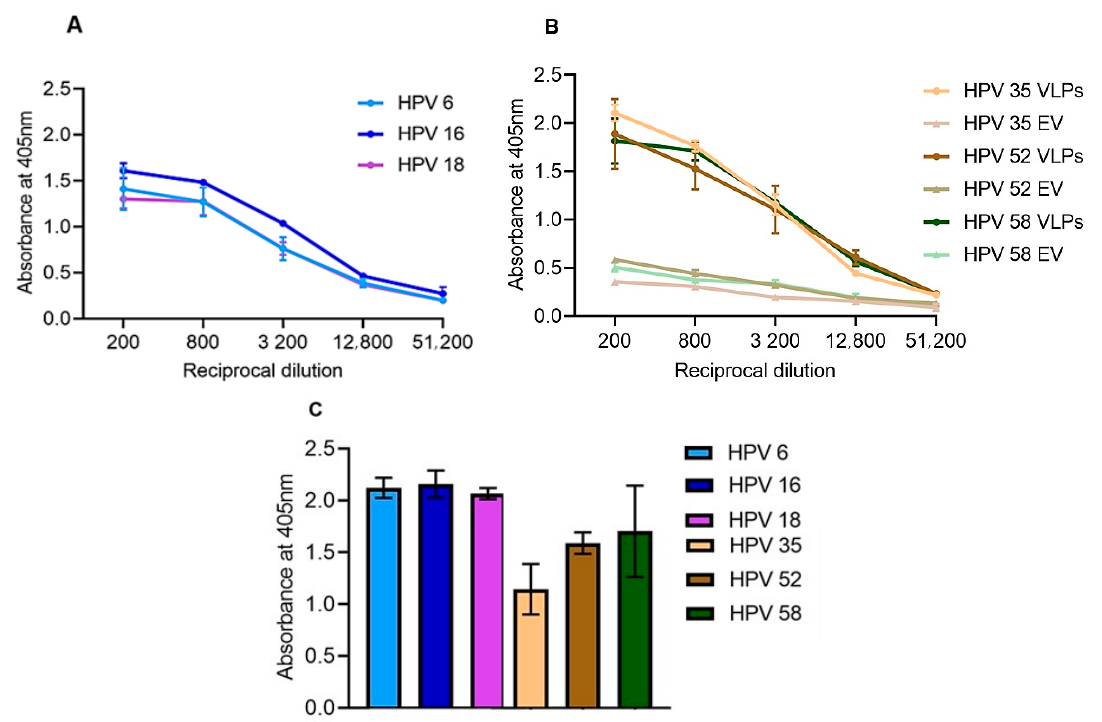
Figure 3. Indirect ELISA to determine anti-L1 titres. Plates were coated with purified plant-produced L1 antigens and final bleed antiserum collected from mice vaccinated with Gardasil ® , plant-produced VLPs and the empty vector negative control (EV) were titrated to determine end-point anti-L1 titres. ( A ) Four-fold serial dilution of pooled sera from mice vaccinated with Gardasil ® and ( B ) plant-produced EV and VLP respectively; ( C ) Plant-produced HPV VLPs were probed with rabbit-raised anti-Gardasil ® positive control sera at a single dilution of 1:5000 to determine if the plant-produced VLPs could be detected by Gardasil ® antisera. Markers and error bars indicate mean values and standard deviation from triplicate readings.